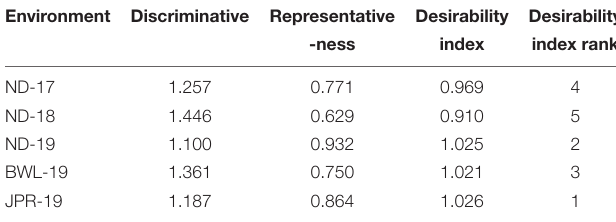
TABLE 5 | Standardized test environment evaluation